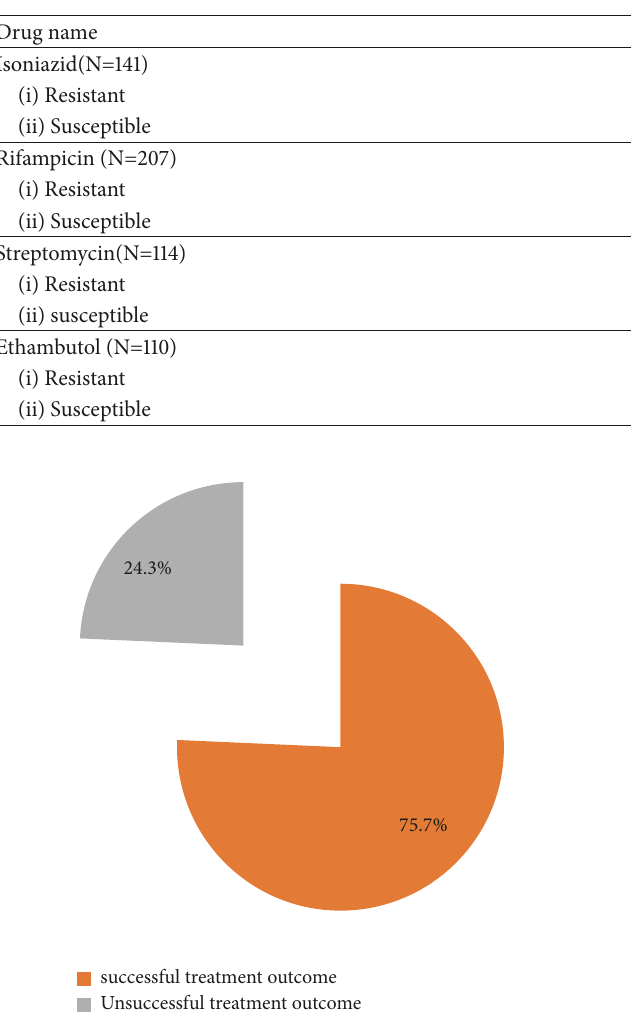
Figure 3: The proportion of successful and unsuccessful treatment outcomes in five years’ time. (2009-2014).